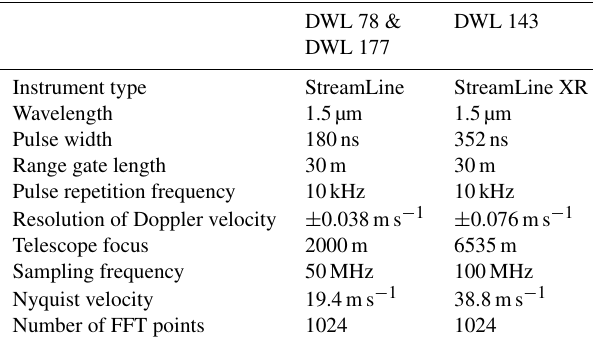
Table 1. Instrument parameters of the three HALO Photonics StreamLine DWL